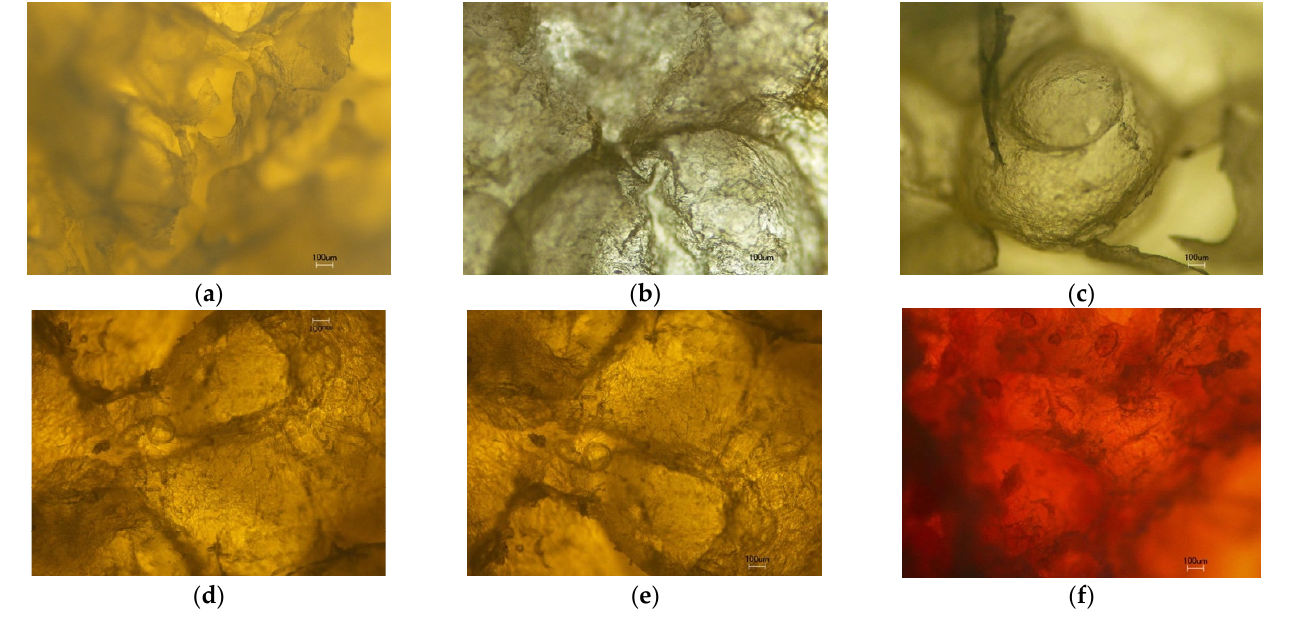
Figure 6. Optical microscopy of the cellular structure of extrudates at 4× magnification, arranged in the order of their starch content, from highest at 79% to lowest at 42%: ( a ) 0:16:64, ( b ) 100% corn, ( c ) 0:56:24, ( d ) 19:31:30, ( e ) 29:25:26, and ( f ) 40:24:16.